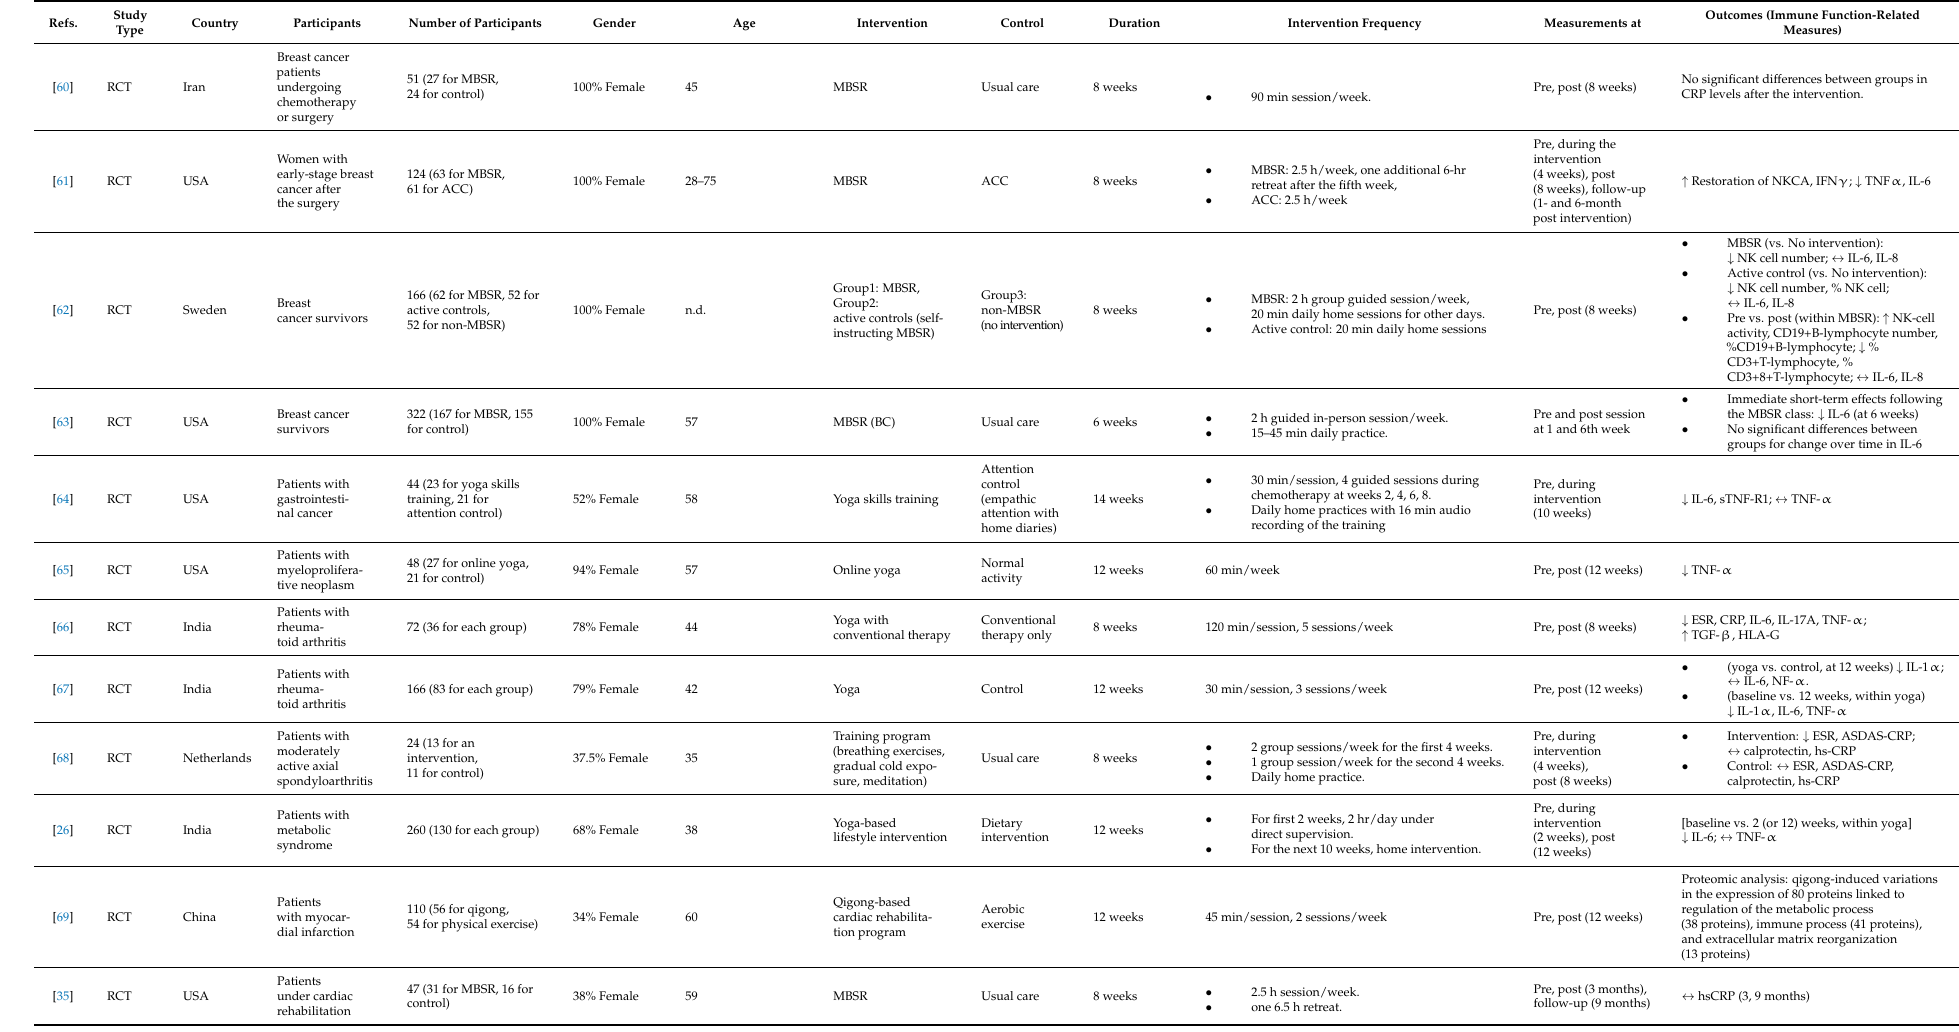
2groupsessions/weekforthefirst4weeks. • 1groupsession/weekforthesecond4weeks. • Dailyhomepractice. Forfirst2weeks,2hr/dayunder directsupervision. •